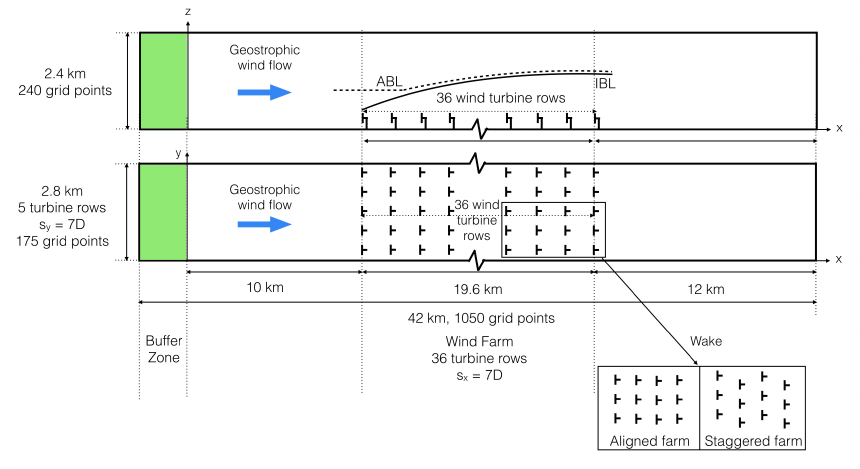
Figure 2. Computational domain and layout of the large finite-size wind farms